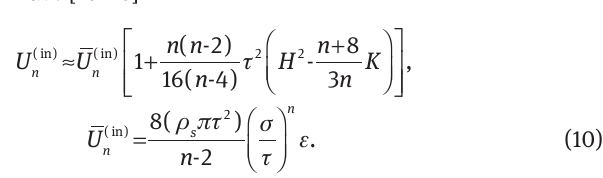
internal structure on gravity, he again treated the sun and the earth as a sphere and a particle, respectively.